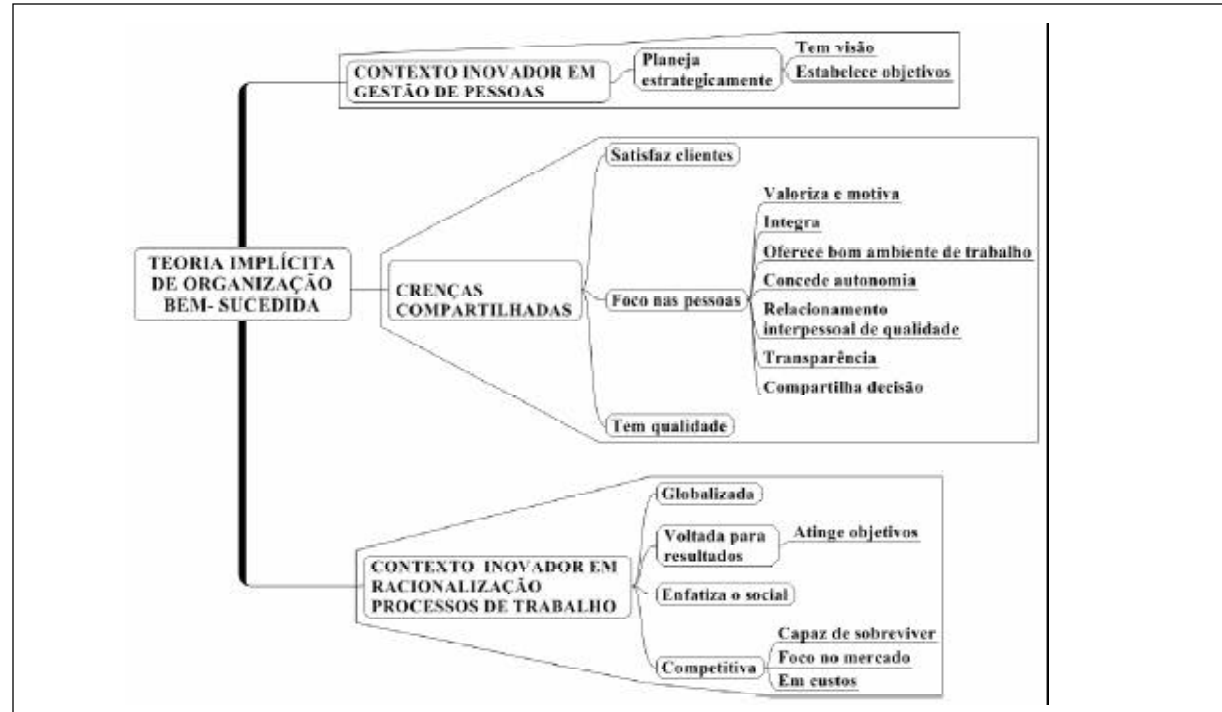
Figura 2 . Teoria implícita de organização bem-sucedida em contextos com diferentes ênfases na inovação.